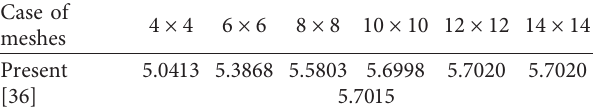
Table 1: Maximum deflections w × 10 − 5 m versus mesh density.